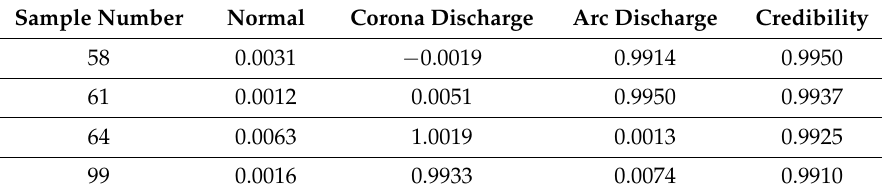
Table 9. Some diagnostic results of neural network model.